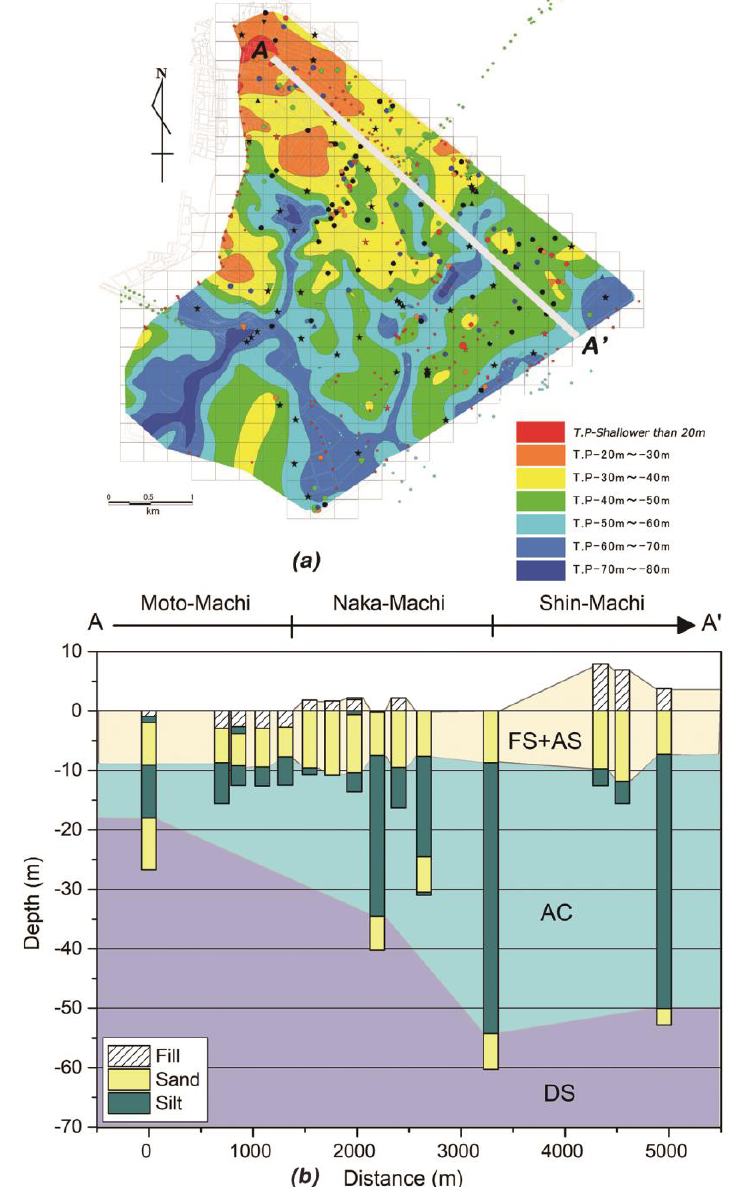
Figure 14. Depth of the upper surface of the solid geological stratum ( a ) in Urayasu City (adapted from the public report by the technical committee of Urayasu City [54]). The points refer to the locations of borehole sites; ( b ) soil cross sections along the A–A’ line. FS + AS refer to filled sandy soil and alluvial sand layers, and AC and DS refer to the alluvial clay layer and diluvial dense sandy layer, respectively. The borehole investigation data were obtained from the Chiba Prefecture [55].